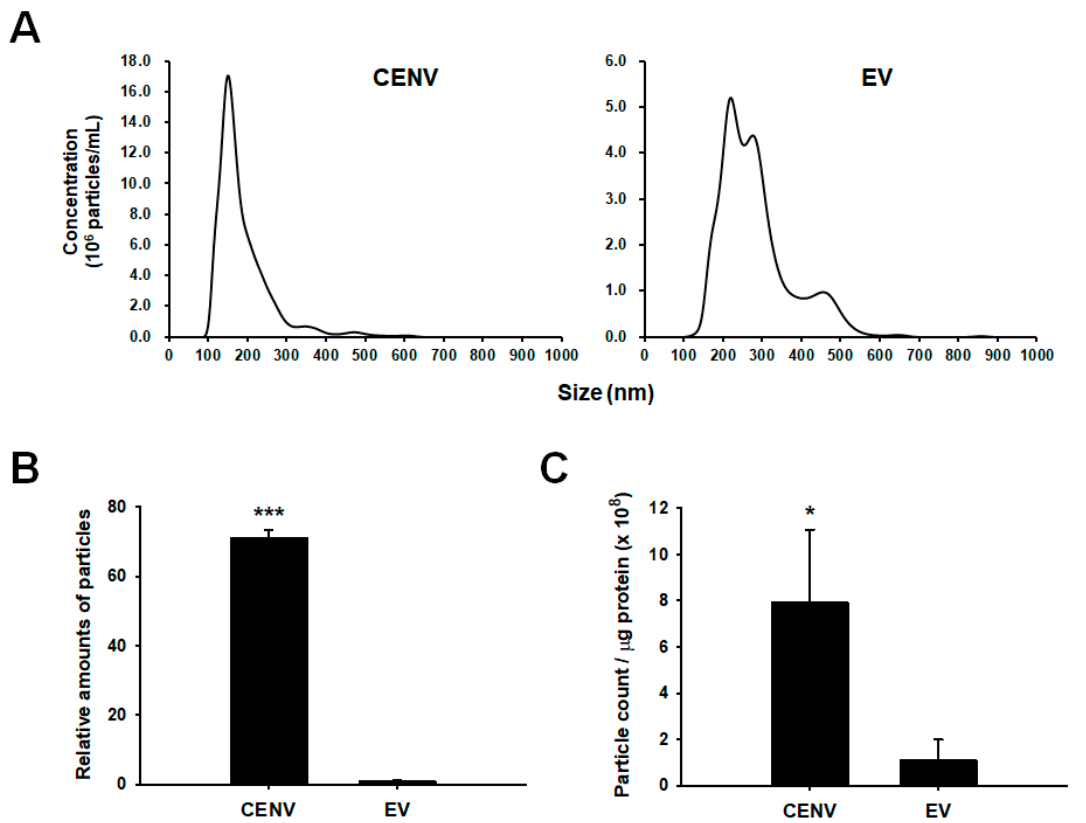
Figure 3. Comparison of human iPSC-derived CENV and EV. ( A ) Size distribution of iPSC-CENVs and iPSC-EVs, as evaluated by nanoparticle tracking analysis (NTA). ( B ) The number of particles isolated from the same number of human iPSCs, as evaluated by NTA. The number of iPSC-CENVs was normalized by that of iPSC-EVs, and represented as a relative value. ( C ) The particle-to-protein ratio of iPSC-CENVs and iPSC-EVs, indicating the relative purity against protein contaminants. Statistical significance (* p < 0.05, *** p < 0.005 compared to EVs) was determined using Student’s t -test. Error bars indicate the standard deviation of triplicate experiments.